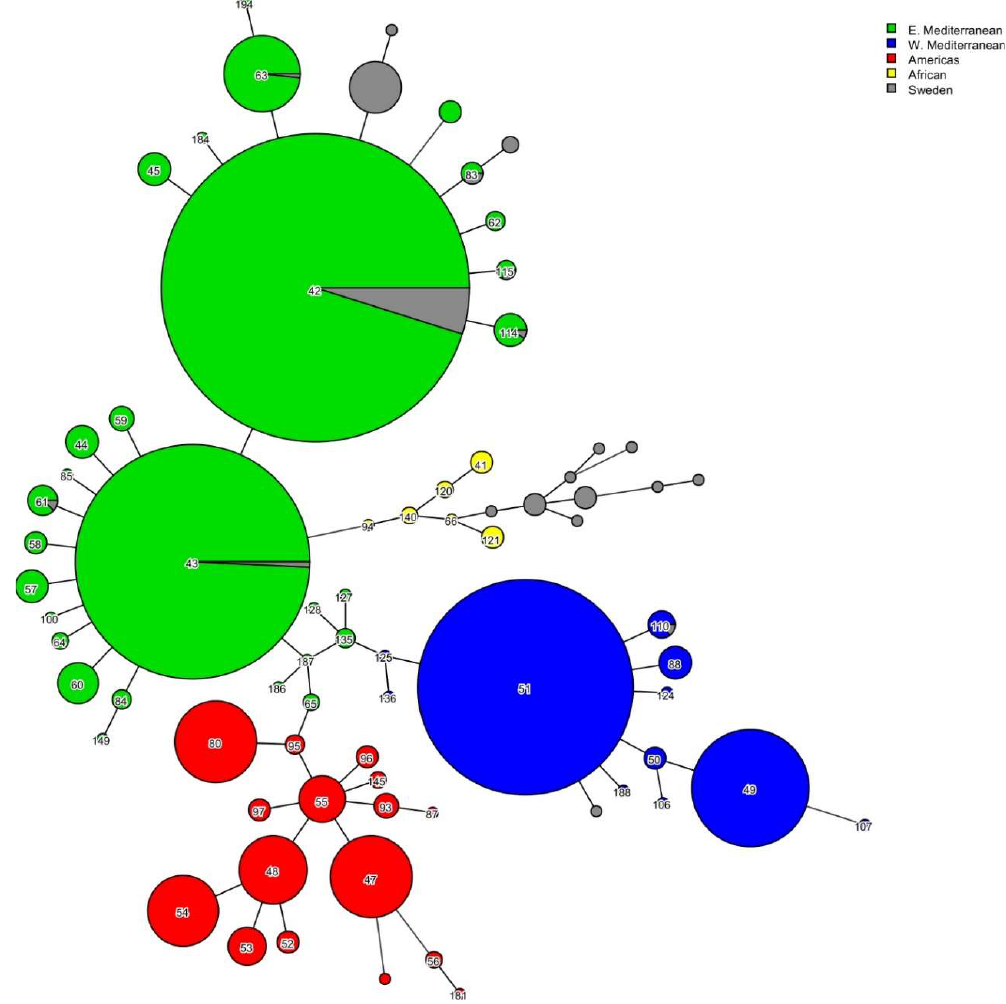
Figure 2. Minimum spanning tree (MST) based on B. melitensis MLVA-8 typing results. The tree was